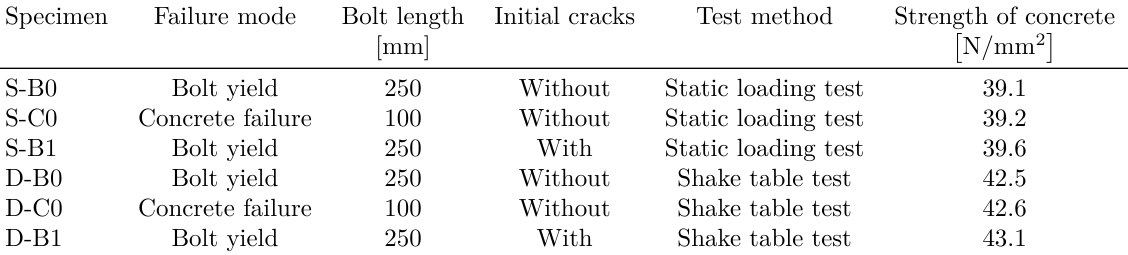
Table 1. Test cases.